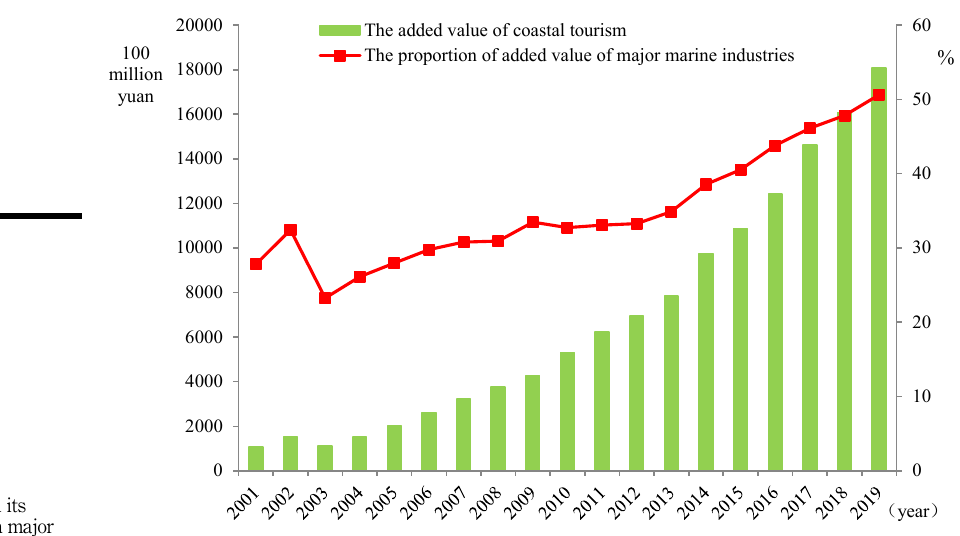
Figure 13. Tourism and its proportion in major marine industries